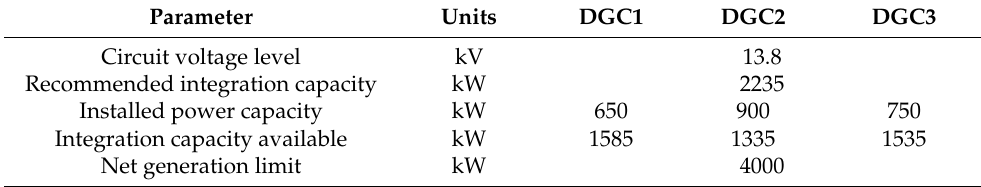
Table 4. Technical characteristics of conventional Distributed generation circuits.